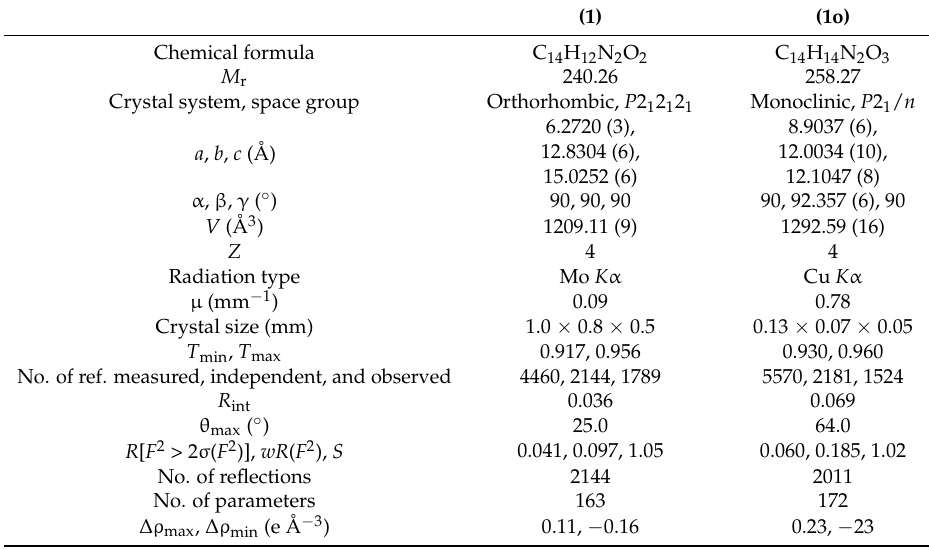
Figure 4. Displacement ellipsoid plots (50% probability) for ( a ) 1-[2-(1 H -indol-3-yl)-ethyl]-pyrrole-2,5-dione, C 14 H 12 N 2 O 2 , 1 and ( b ) its open analogue, 1o . Atom numbering of non-H atoms is presented. Table 1. Experimental details of the crystal structure determination.